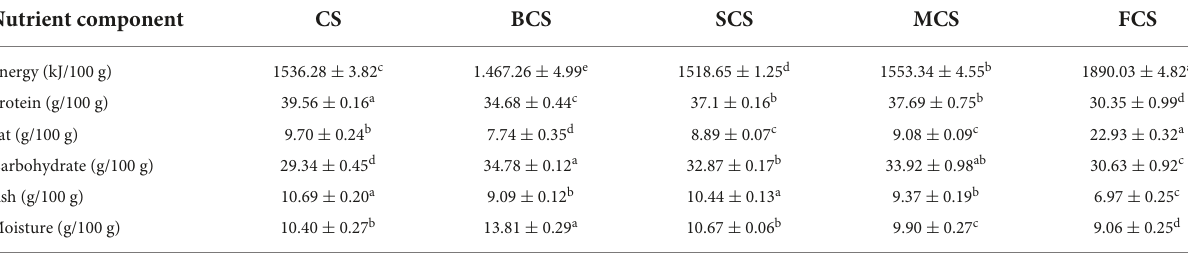
TABLE 4 Effects of different cooking methods on conventional nutrient components in C. squamulosa. Nutrient